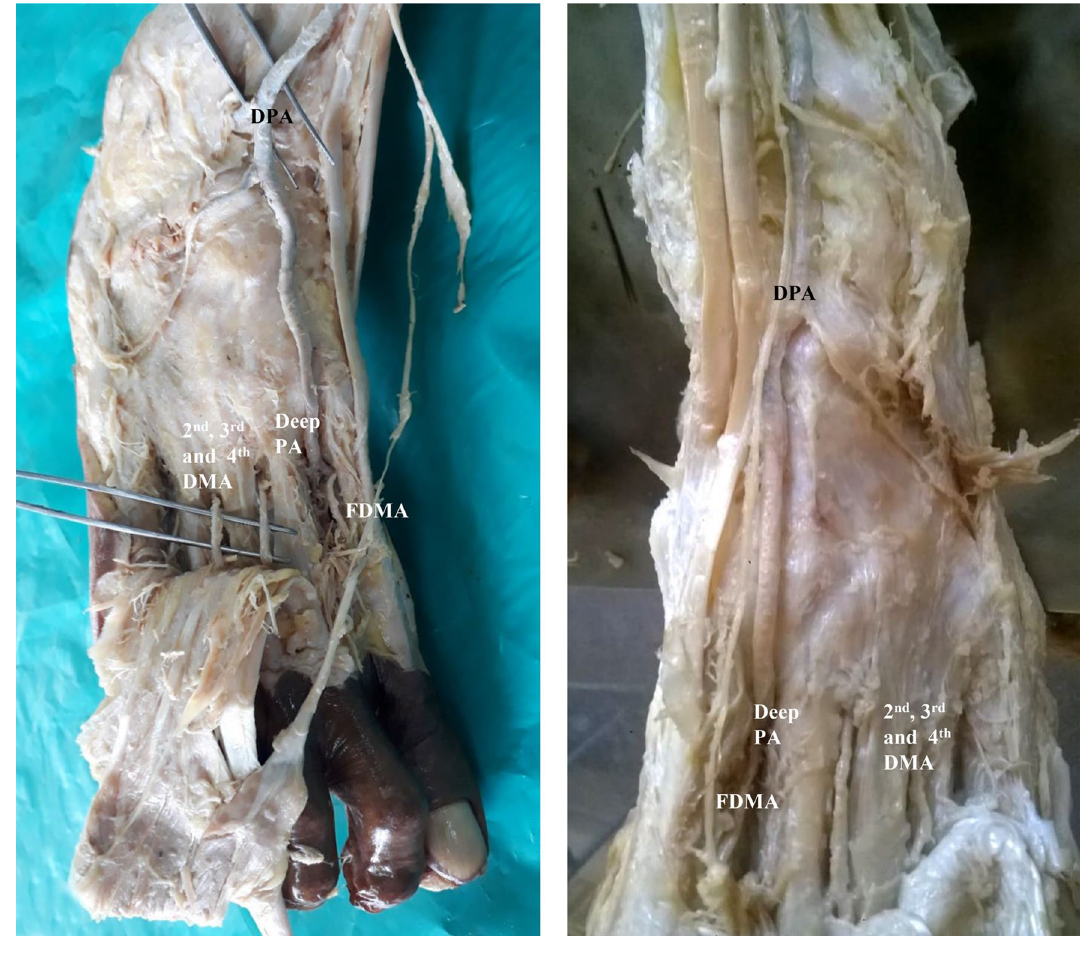
Figure 6. Absence of arcuate artery with dorsal metatarsal arteries arising from plantar arch. FDMA-First dorsal metatarsal artery, Deep PA-Deep plantar